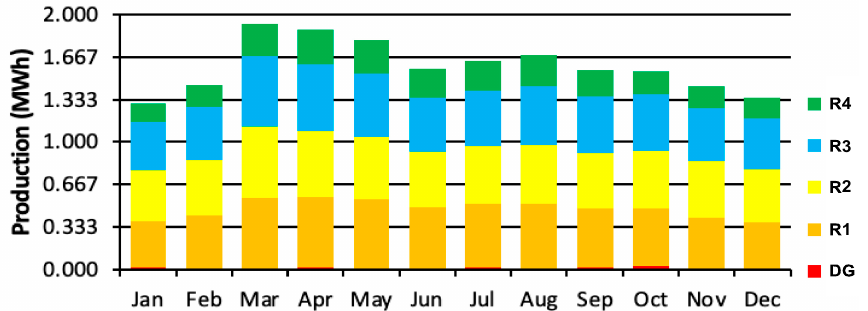
Figure 15. Monthly electricity production of the OSC at 22 kWh/day.